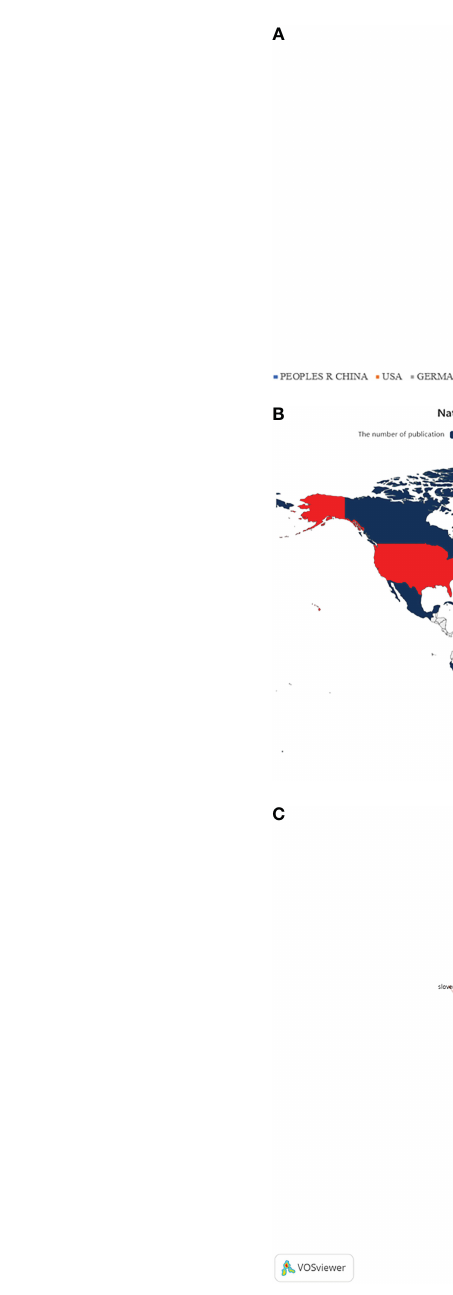
FIGURE 2 The regional distribution. (A) The top 10 countries/regions contributed to the fi eld of tumor ablation and immunity. (B) The distribution of countries/ regions in terms of publications. (C) A network map of